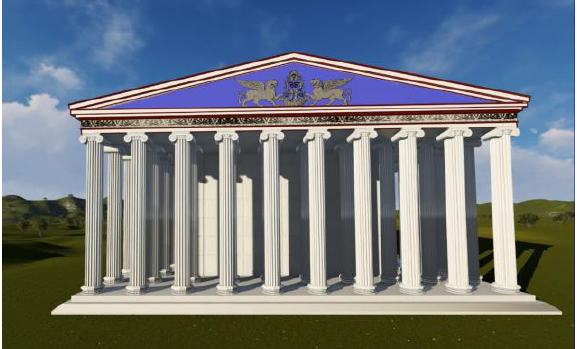
Figure 10. 3D Visualisation of the grandiose of the finished